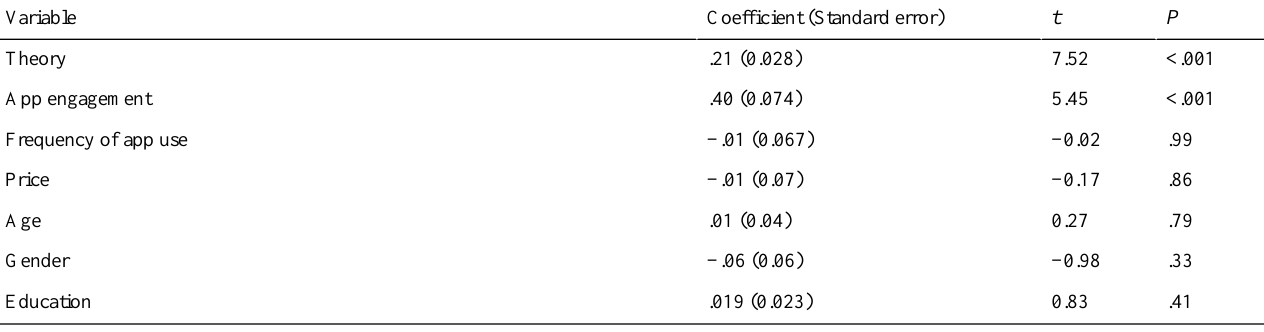
Table 6. Regression analysis and physical activity